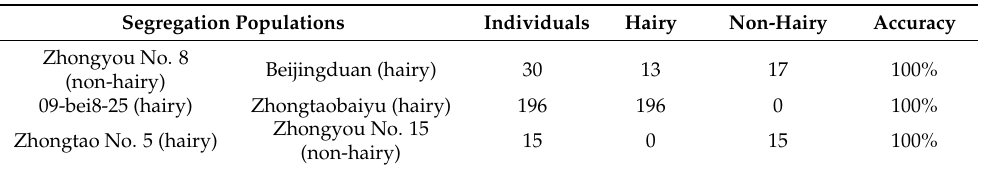
Figure 5. Three types of SNPs (T/T, T/G, and G/G) linked to peaches’ skin hairiness/non-hairiness in 122 cultivars (lines), based on Sanger sequencing results. in 122 cultivars (lines), based on Sanger sequencing results. Table 3. The SNP marker was used for MAS in three segregation populations to predict the phenotype with 100%